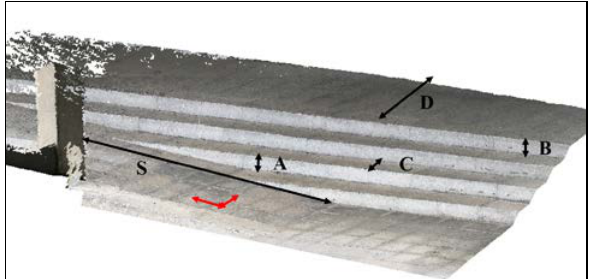
Figure 8. Stairs and ramp scenario. 3D reconstructed point